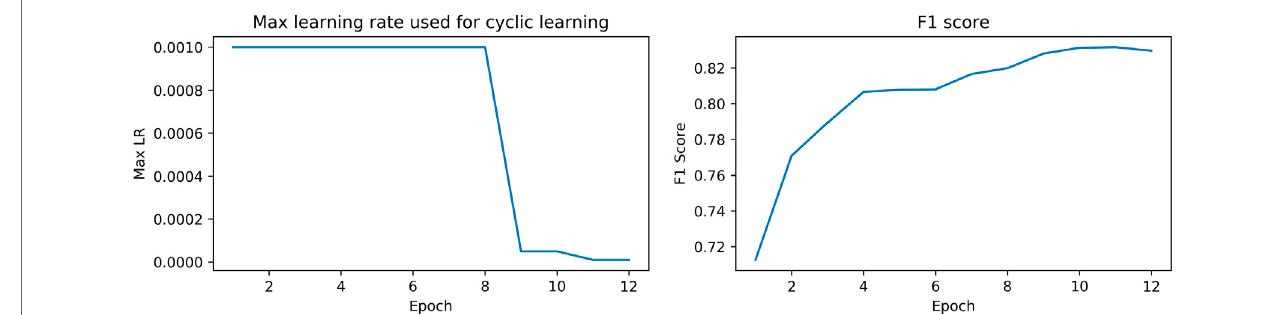
FIGURE 4 | Max learning rate schedule and corresponding F1 score.